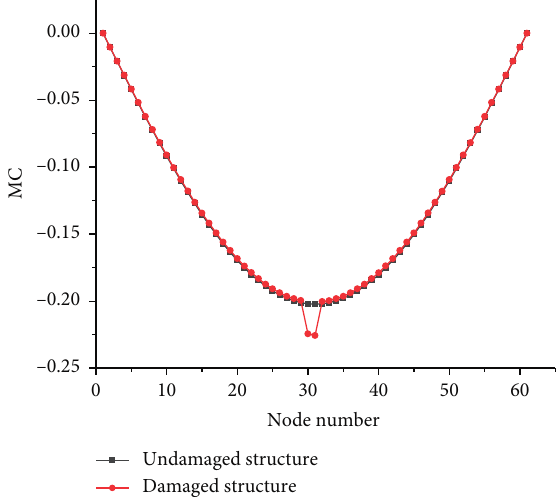
Figure 5: MC curves of structure before and